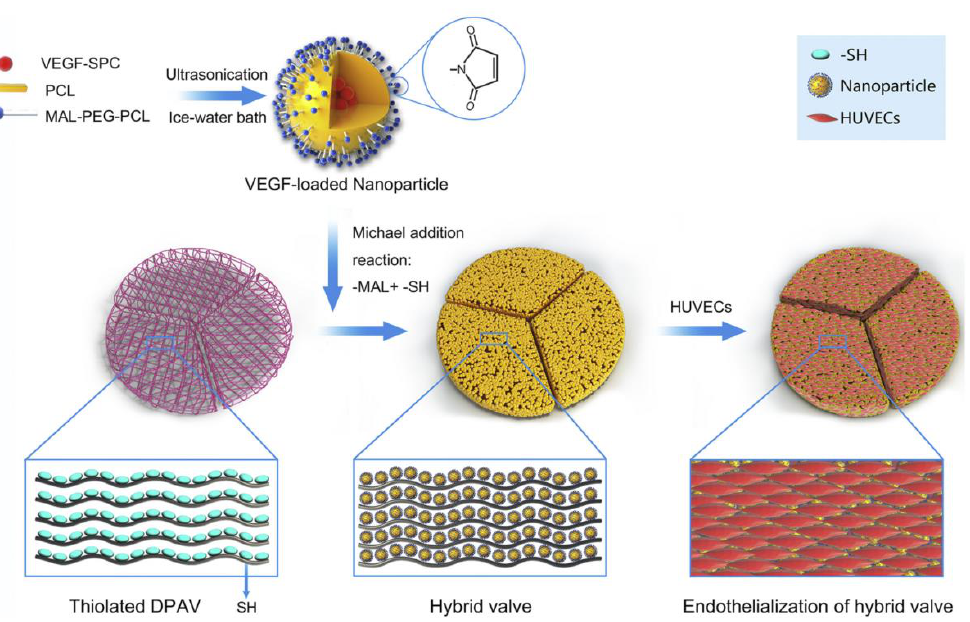
Figure 4. Preparation scheme of VEGF-loaded nanoparticles and endothelialization of the hybrid valve (adapted from Ref. [96]). Table 3. Application of different nanocomposites in the study of tissue-engineered heart